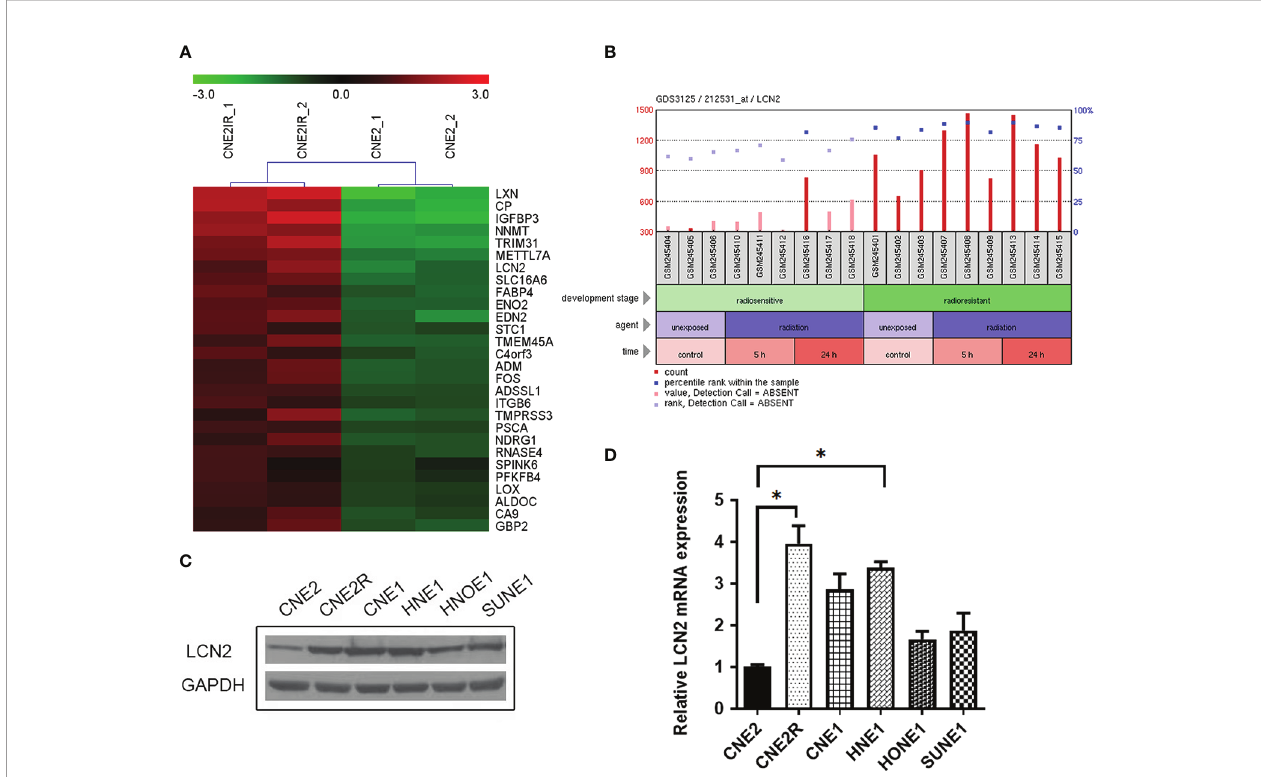
FIGURE 1 | LCN2 was identi fi ed as a radioresistance-related gene in nasopharyngeal carcinoma (NPC). (A) A heatmap of the overlapping differential expressed genes (DEGs) between the radiosensitive cell line CNE2 and the radioresistant cell line CNE2R in GSE48501. (B) The responses of radiosensitive and radioresistant squamous cell carcinomas (SCCs) to ionizing radiation (time course). LCN2 expression was upregulated in both radioresistant and radiosensitive SCCs after irradiation. (C, D) Validation of LCN2 expression in NPC cell lines. LCN2 protein (C) and mRNA (D) levels were examined by western blotting and quantitative real- time PCR (RT-qPCR), respectively. GAPDH was used as an internal control. * P <